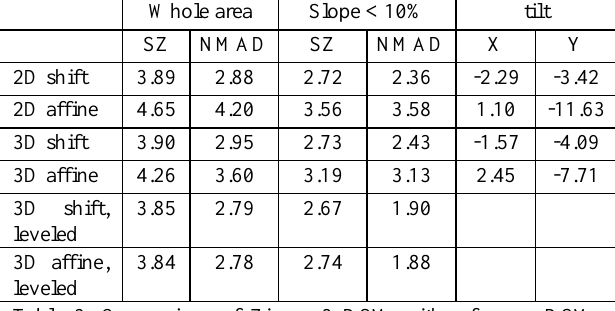
Table 3. Comparison of Ziyuan-3 DSM with reference DSM from aerial images, depending upon type of orientation; for non-forest